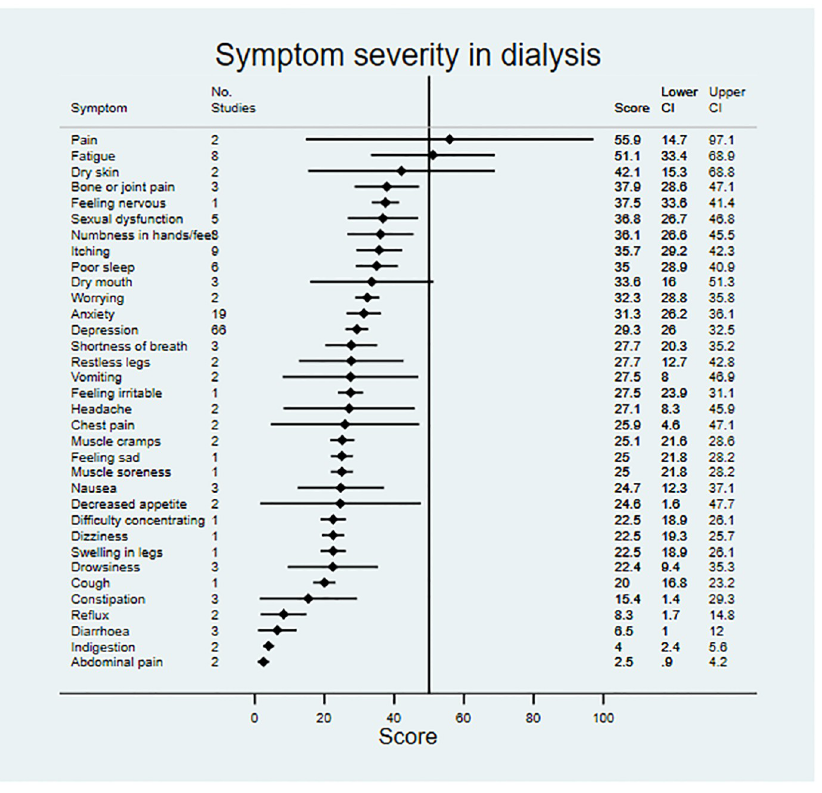
Fig 6. Pooled symptom severity across included studies for patients on dialysis. Scores represent mean severity scores converted to a 0–100 scale, where a higher score indicates greater severity; vertical line at 50 for reference.